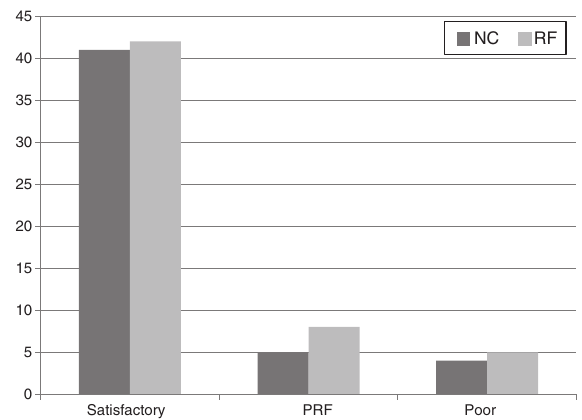
Long-term pain relief in nerve combing (NC) and percutaneous radiofrequency thermocoagulation (RF) groups ( p > 0.05).